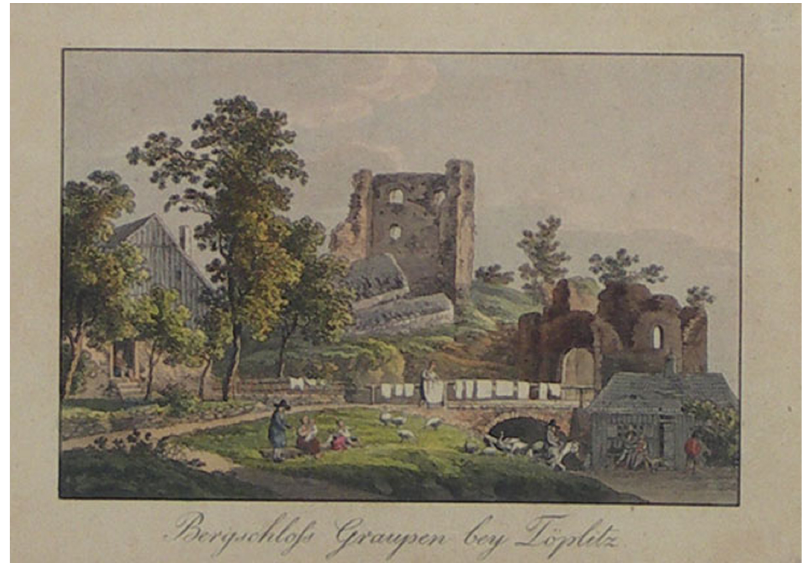
Figure 39. Unknown artist. Bergschloß Graupen near Töplitz , c. 1830.